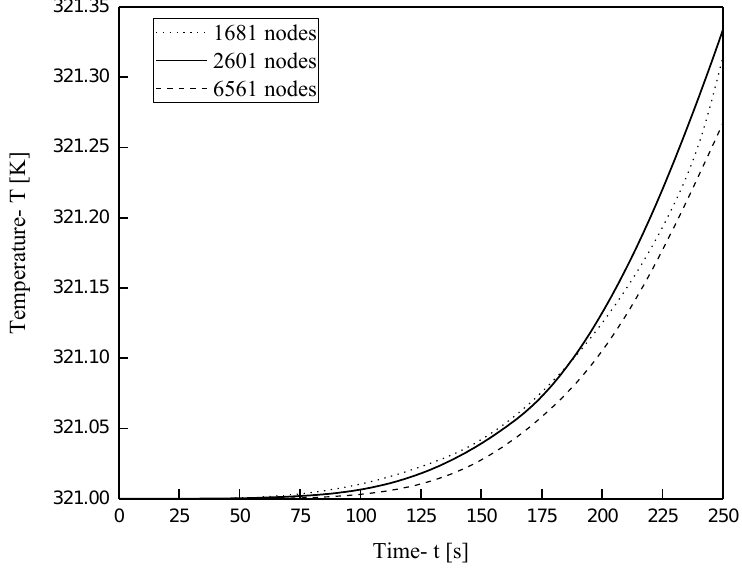
Energies 2020 , 13 , x FOR PEER REVIEW Figure 3. Grid density of the domain used in the numerical solution. Figure 3. Grid density of the domain used in the numerical solution.